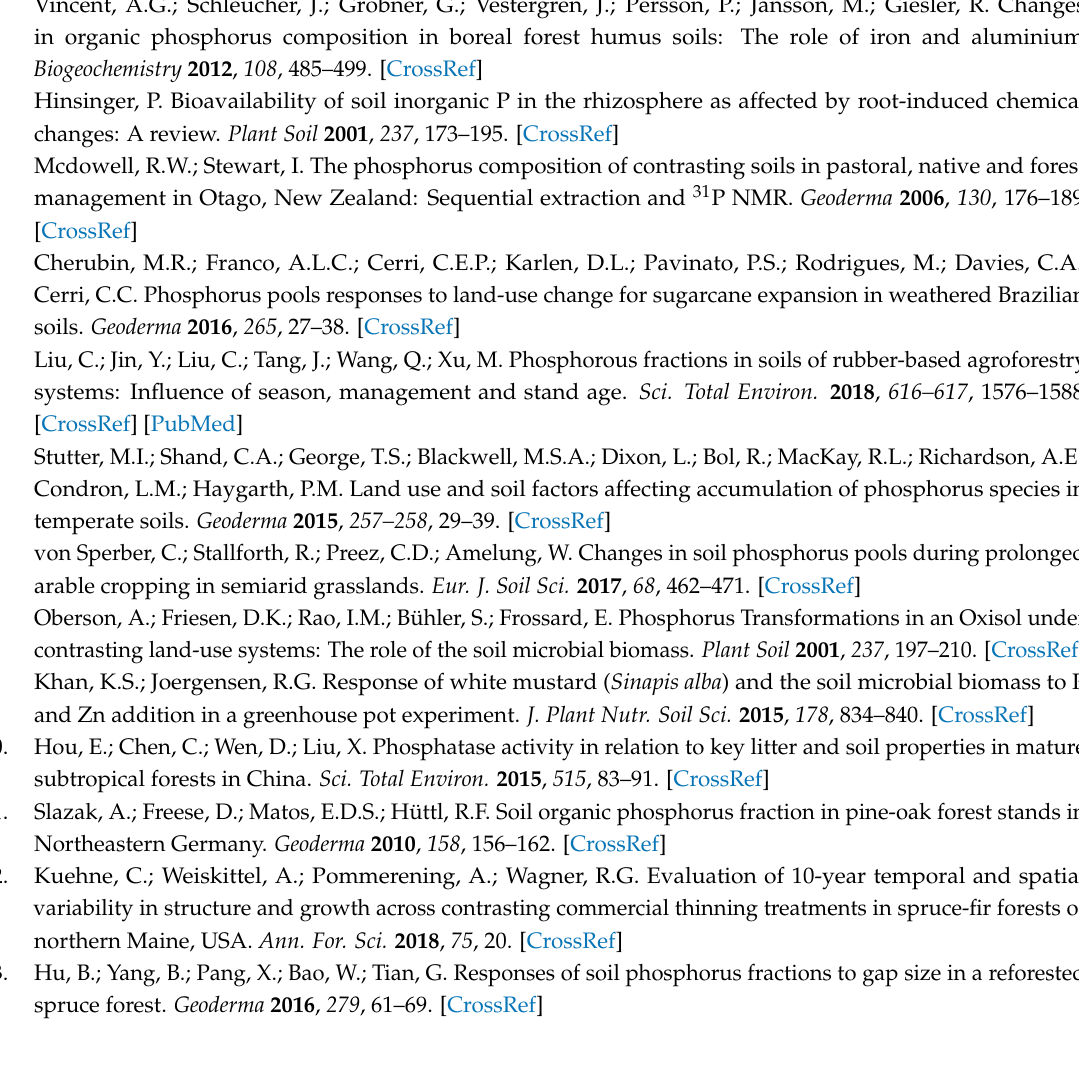
Table S1: The average of soil P fractions (mg kg − 1 ) in four thinning treatments across seasons. Table S2: The average of soil P fractions (mg kg − 1 ) in four sampling times irrespective of the